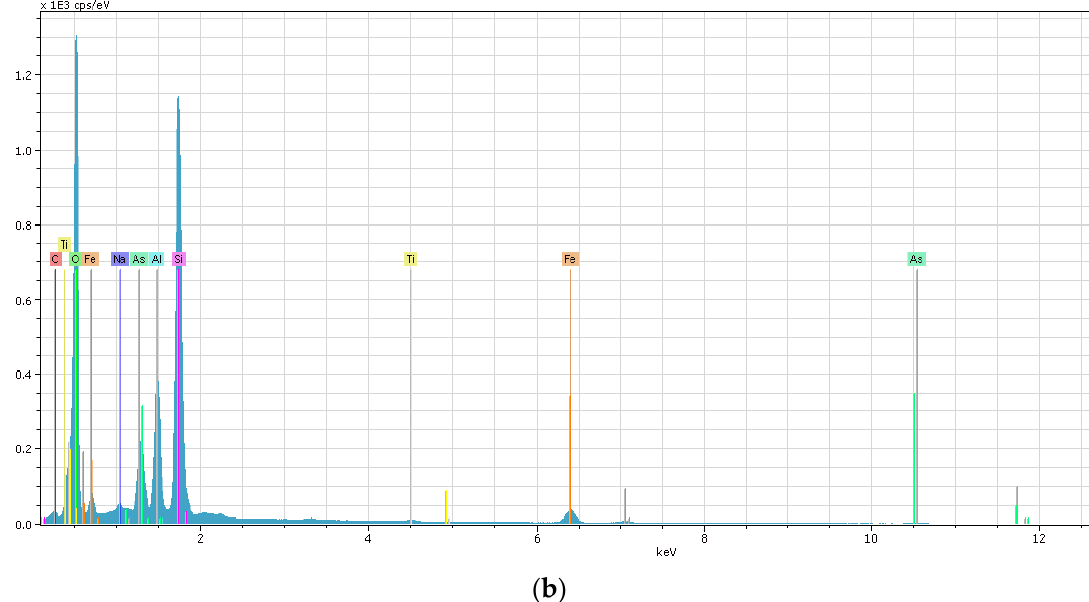
Figure 8. EDXS spectra of fines of ( a ) original Skye sand and ( b ) Skye sand after treatment.